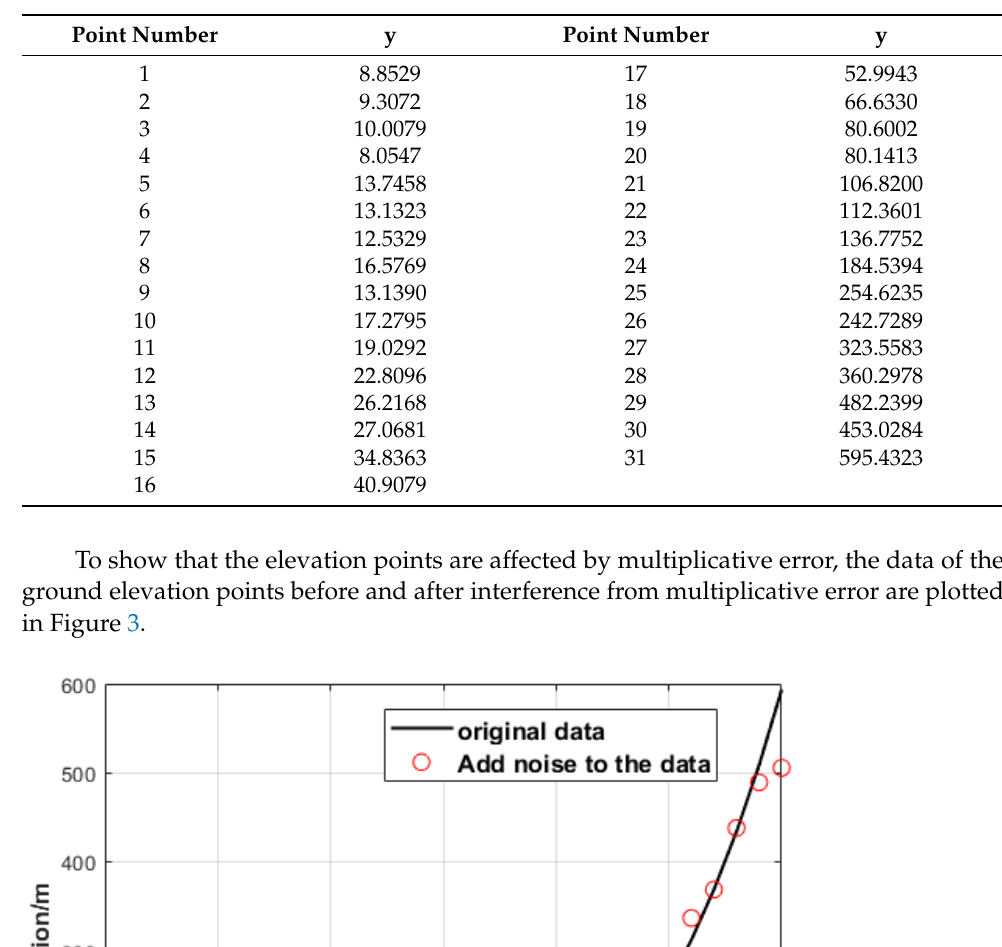
Table 1. Simulation Data.